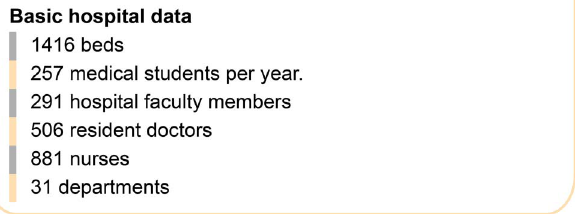
Figure 2. Characteristics of Lokmanya Tilak Municipal General Hospital. Abbreviations: ICU Intensive Care Unit.